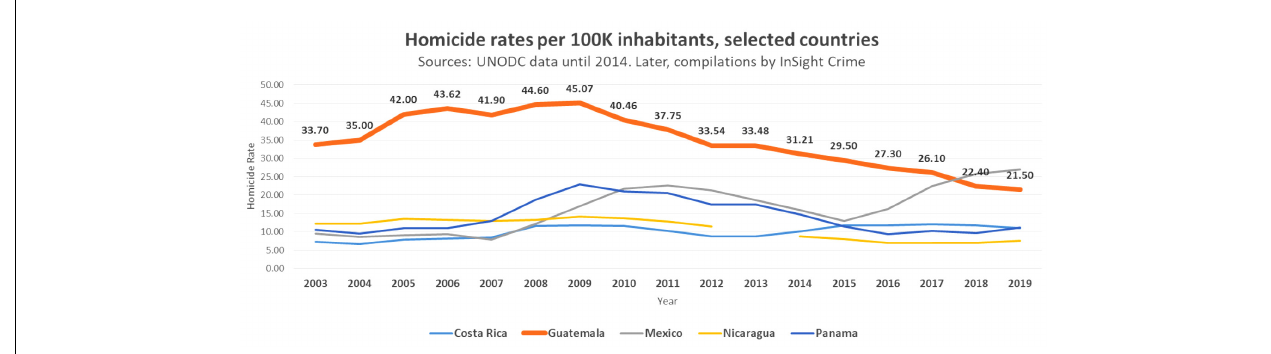
Figure 3. Homicide rates per 100K inhabitants, selected